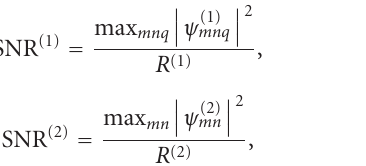
= 1 mS/m ( σ = 0 . 001 D D